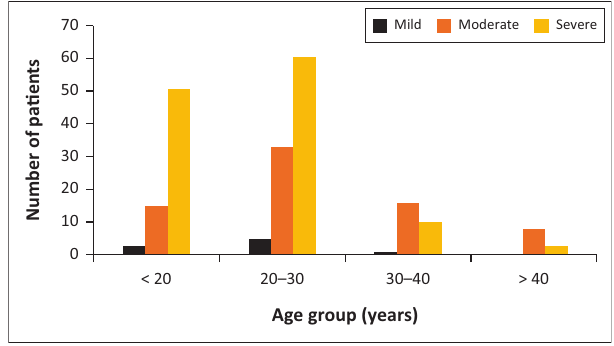
FIG URE 4: Bar graph indicating the severity of the 206 keratoconus patients seen at the University of Johannesburg contact lens clinic with respect to age groups.